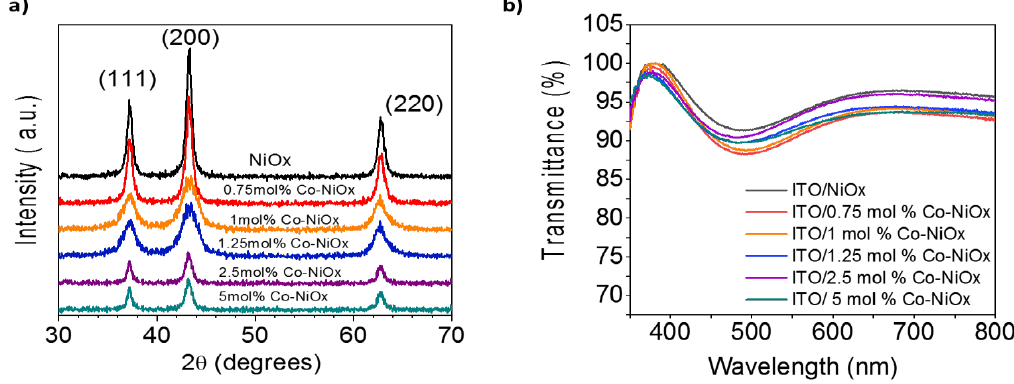
Figure 3. ( a ) X-ray diffraction (XRD) patterns of the NiO x and Co-doped NiO x nanoparticles; ( b ) optical transmission spectra for the NiO x and Co-NiO x films fabricated on top of ITO substrates, where the thickness of the Co-NiO x films was around 37 nm.